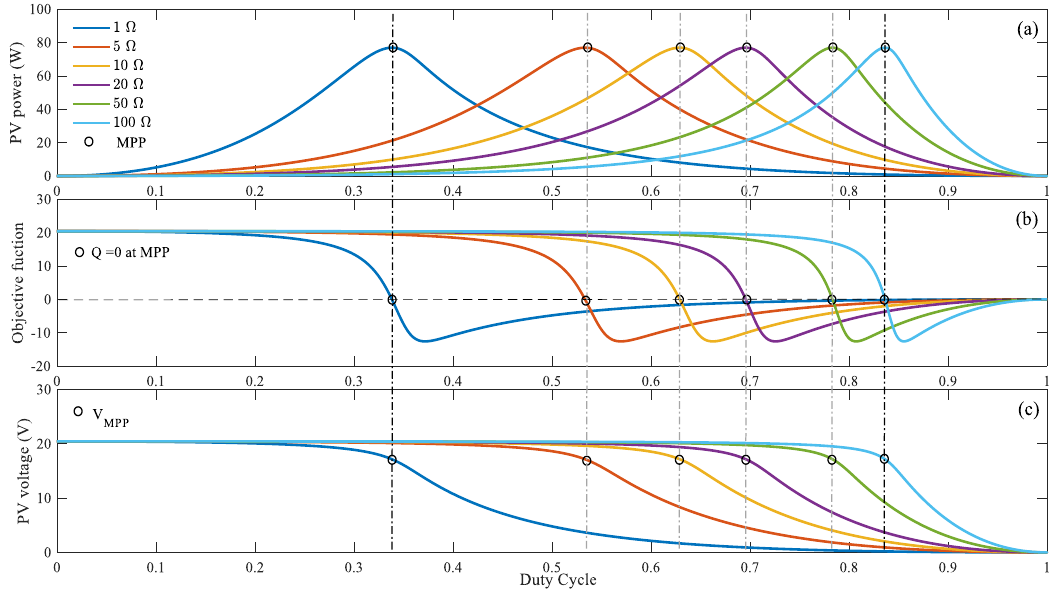
Figure 5. Electrical characteristics of the PV-buck-boost converter under variation of the load with fixed irradiance at 900 W/m 2 ( a ) P-D characteristics, ( b ) Q-V characteristics, and ( c ) V-D characteristics.